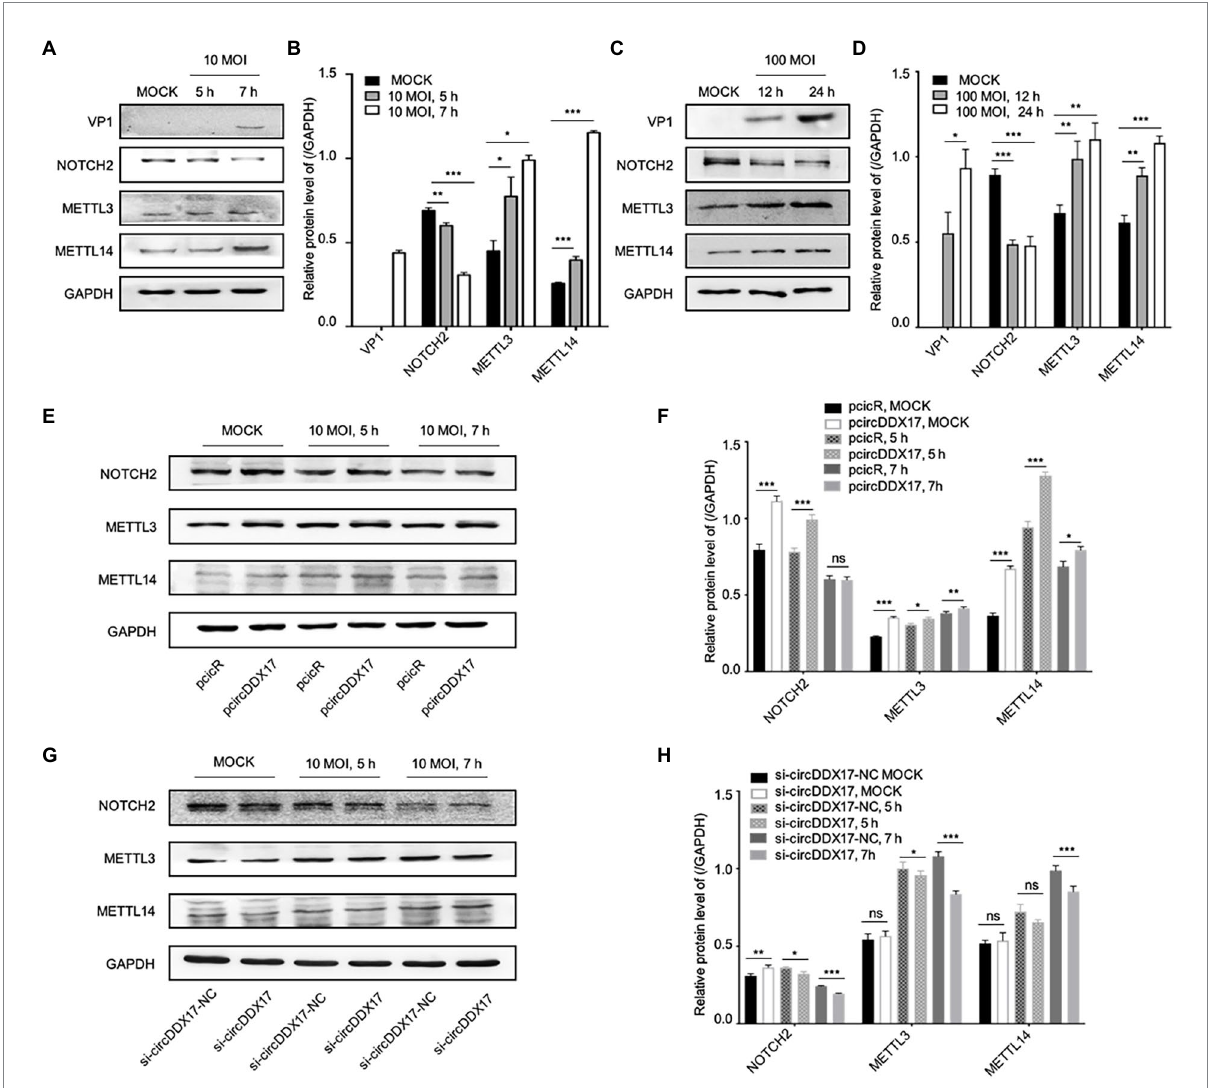
FIGURE 4 CircDDX17 regulates NOTCH2 expression and influences methylation-related pathways after CVB3 infection. (A,B) HeLa cells infected CVB3 (10 MOI) for 7 h, signals were detected by Western blot. (C,D) HL-1 cells infected CVB3 (100 MOI) for 24 h, signals were detected by Western blot. (E,F) HeLa cells overexpression circDDX17 by pcircDDX17, cells infected CVB3 (10 MOI) for 7 h, indicated signals were detected by Western blot. (G,H) HeLa cells silenced circDDX17 by si-circDDX17, cells infected CVB3 (10 MOI) for 7 h, indicated signals were detected by Western blot. * p < 0.05, ** p < 0.01, *** p <